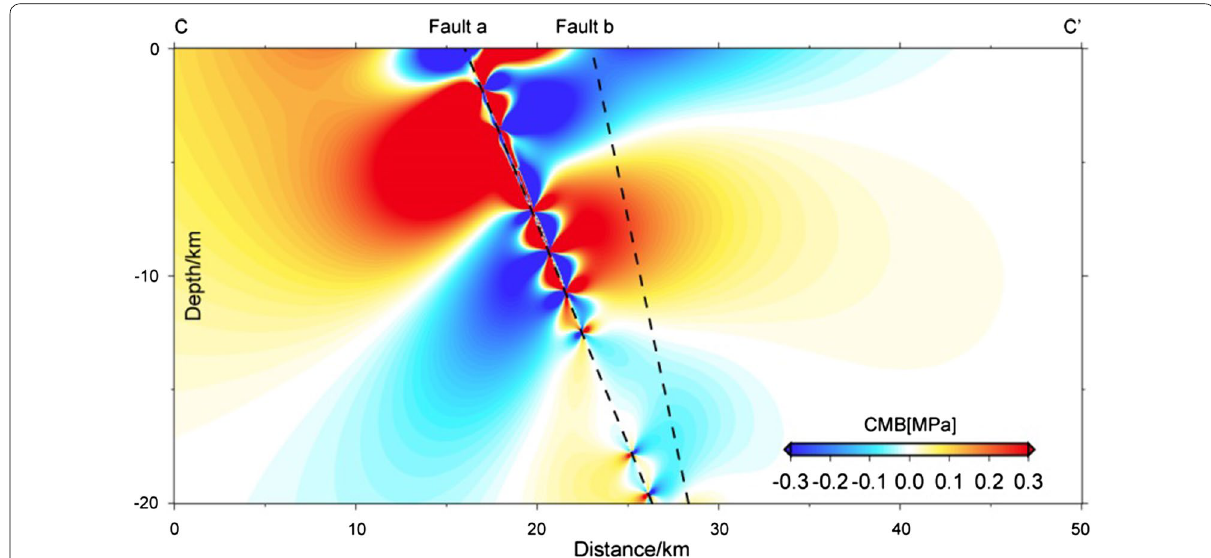
Fig. 8 Coseismic Coulomb stress change caused by the slip on Fault a. The location of the C–C ′ profile is shown in Fig.